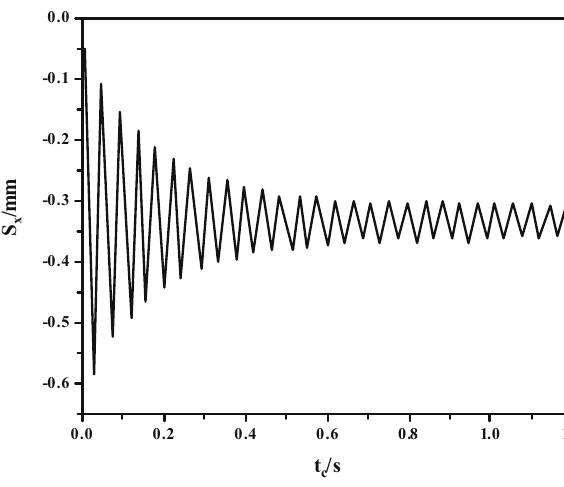
Figure 2: Variation of displacement with FSI calculation